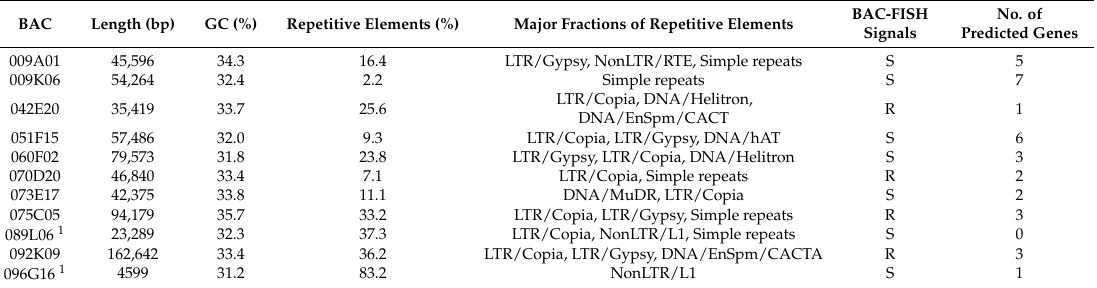
Table 4. Characterization of BAC clone sequences.